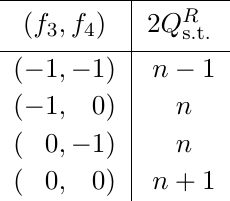
Table 1 . The boundary R-charge of the Ramond ground states for a given value of n = 2 j − 1+ kw and the fermion numbers f 3 , 4